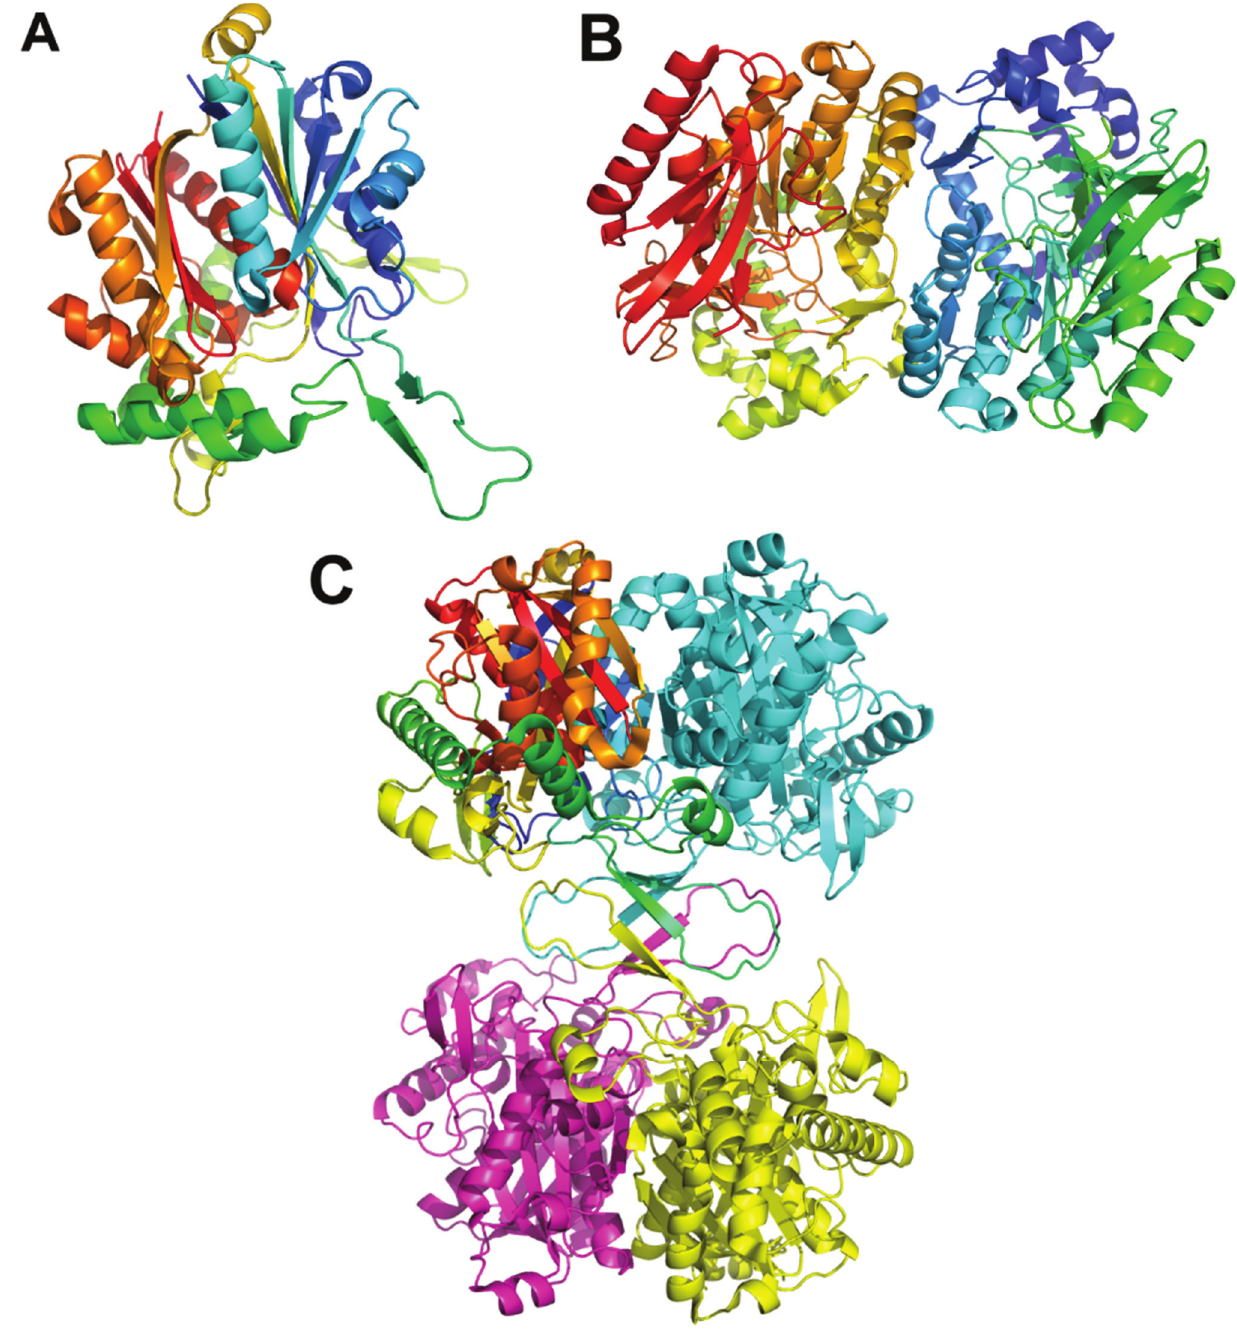
Figure 4. The Thermus thermophilus HB8 PaaJ. The biological unit is a dimer of dimers. ( A ) The cartoon representation of the PaaJ monomer painted in rainbow color from blue at the N-terminus to red at the C-terminus. The structure is composed of five layers (cid:4)/(cid:2)/(cid:4)/(cid:2)/(cid:4). ( B ) The cartoon representation of a tightly bound dimer. The second monomer is in cyan. ( C ) The tetramer, third monomer is in magenta and fourth in